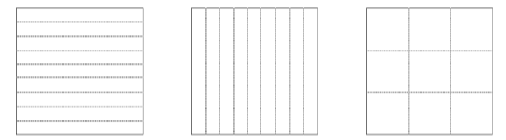
Figure 2. Three regular domain decomposition methods (rows, columns, blocks)